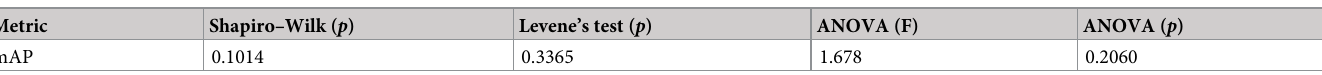
Table 10. Consolidated results of Shapiro–Wilk, Levene, and one-way ANOVA